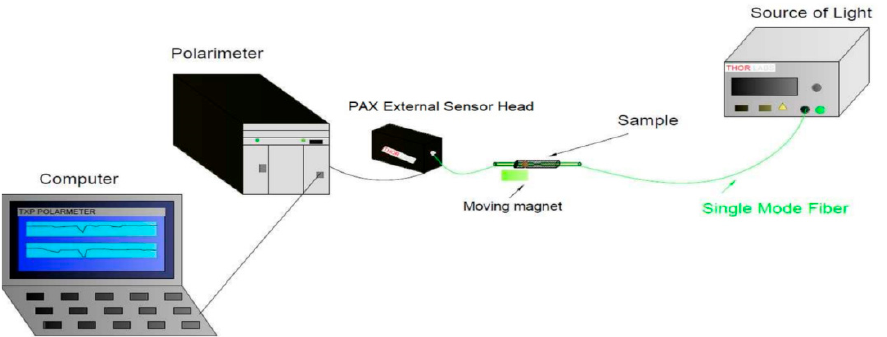
Figure 9. The arrangement for measuring the polarization parameters of a magnetic sensor for different wavelengths of 850 nm and 1550 nm.